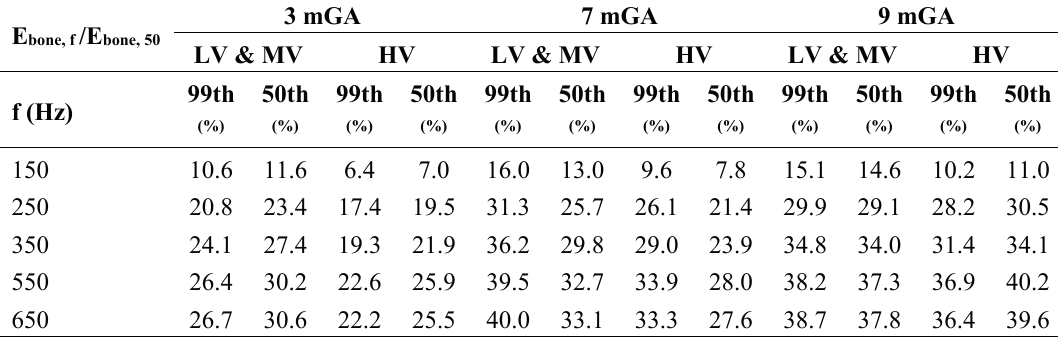
Table 6. Relative percentage of the E 99th and E 50th in the foetal bone at the harmonic frequencies with respect to the same quantities calculated at 50 Hz, for 3, 7 and 9 months GA, and for both the supply networks, when the harmonic content at the source was set according to the percentage provided by the standard EN